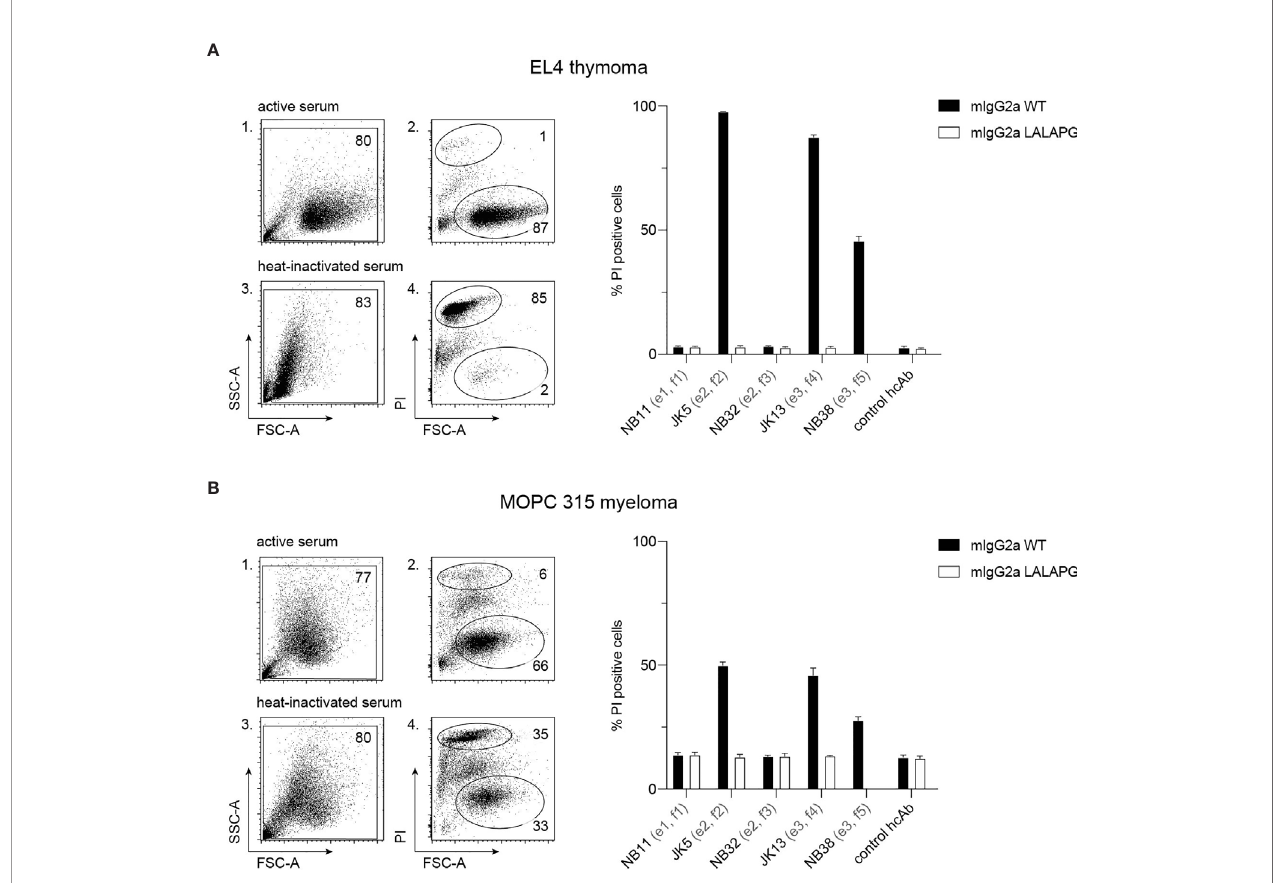
FIGURE 4 | hcAbs of families 2, 4, and 5 mediate complement-dependent cytotoxicity of cells against CD38-expressing thymoma and myeloma cell lines. EL4 thymoma (A) and MOPC 315 myeloma (B) cells were incubated for 120 min at 37°C with the indicated CD38-speci fi c mouse IgG2a hcAbs in the presence of 25% guinea pig serum as a source of complement. The same serum was pretreated for 10 min at 70°C to inactivate complement components and used as a control (heat-inactivated serum). As additional controls, we used LALA-PG mutant hcAbs (with abrogated C1q-binding) and a non-binding control hcAb. Cells were stained with propidium iodide and analyzed by fl ow cytometry to quantify the percentage of dead (PI-positive, FSC low ) cells. Gating was performed to exclude cellular debris with very low FSC and low SSC. Numbers in panels 1-4 indicate the percentage of cells in the indicated gated populations. Data in the bar diagrams represent mean ± SD from three independent